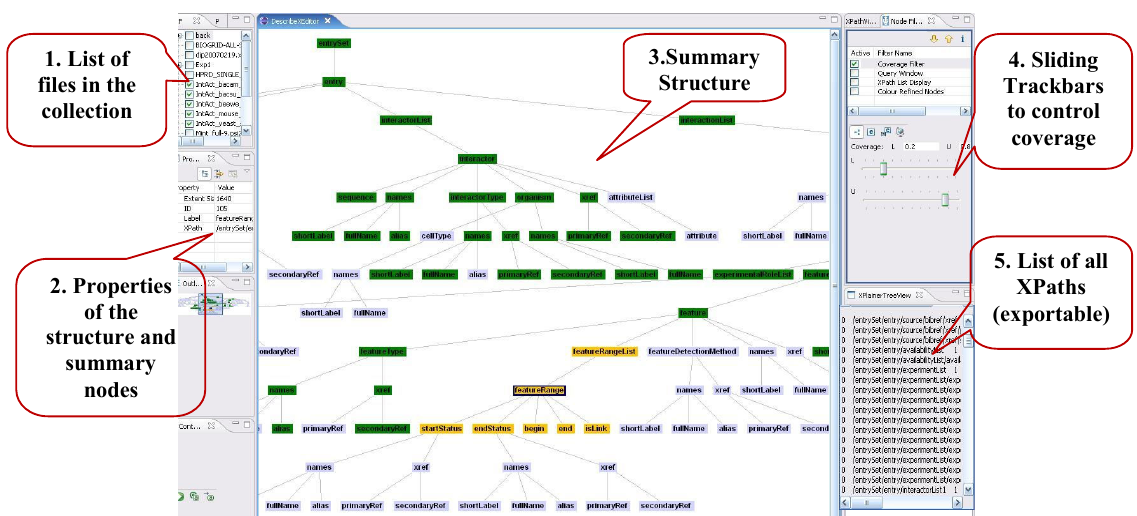
Figure 1: A screenshot of the DescribeX